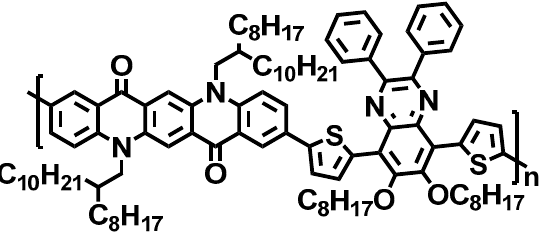
Figure 1. Molecular structure of PQCTQx.